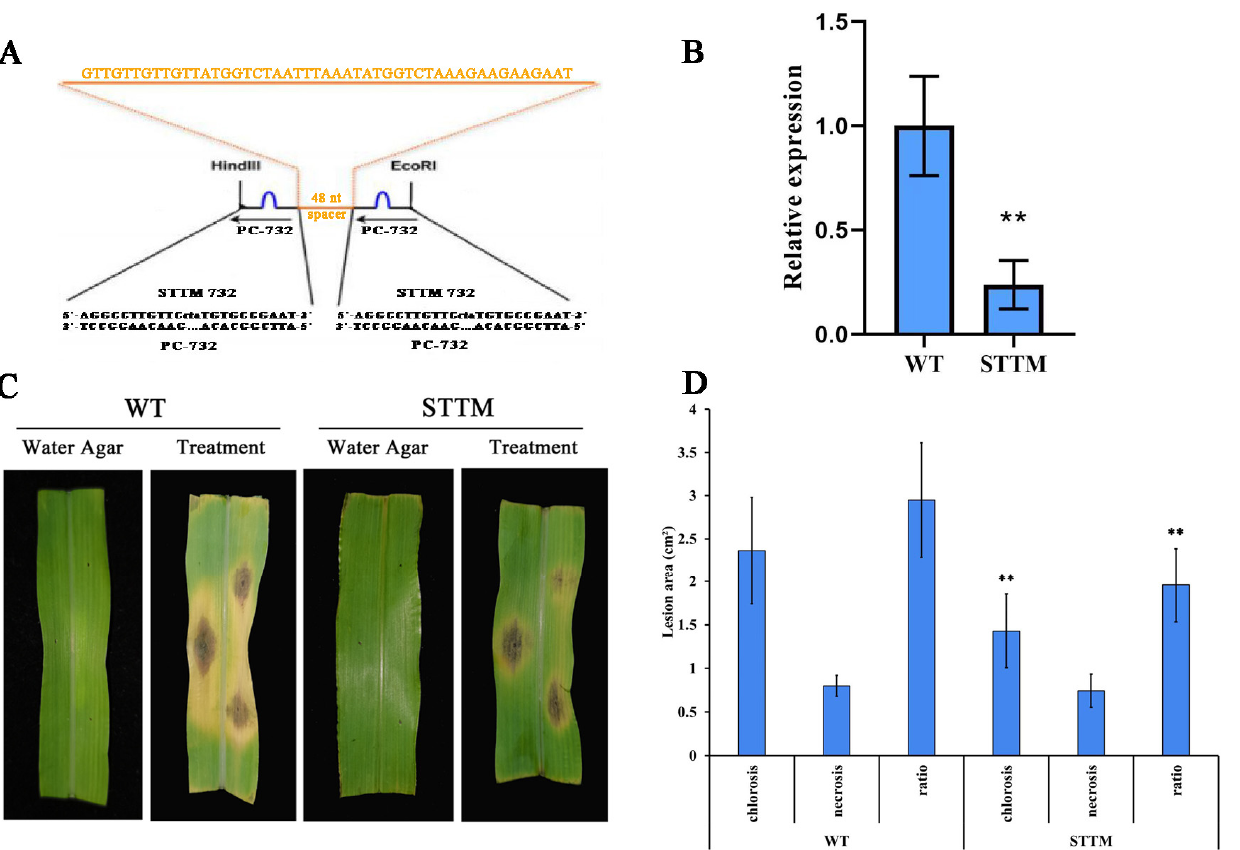
Figure 10. Knocking down PC-732 decreases susceptibility of maize to C. lunata . ( A ) The inhibitory expression vector STTM732 constructed through STTM (short tandem target mimic) technology. ( B ) The expression of PC-732 in transgenic plants were tested through stem-loop RT-PCR. “**” means significant difference ( p < 0.01) between transgenic plants (STTM) and wildtype (WT). ( C ) The maize plants (WT and STTM) were inoculated by mycelium plugs of C. lunata and plugs of water agar were used as control. ( D ) Lesion area of chlorosis and necrosis on maize leaf (WT and STTM) inoculated by C. lunata were measured by Image J and ratio of chlorosis to necrosis was calculated. “**” means significant difference ( p < 0.01) between STTM and WT.